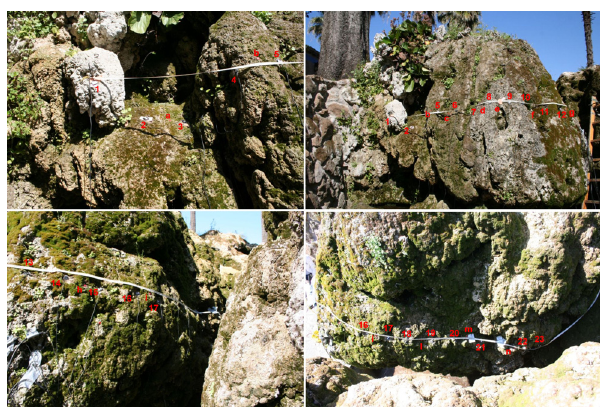
Figure 8. Interation between reflectance and RGB values